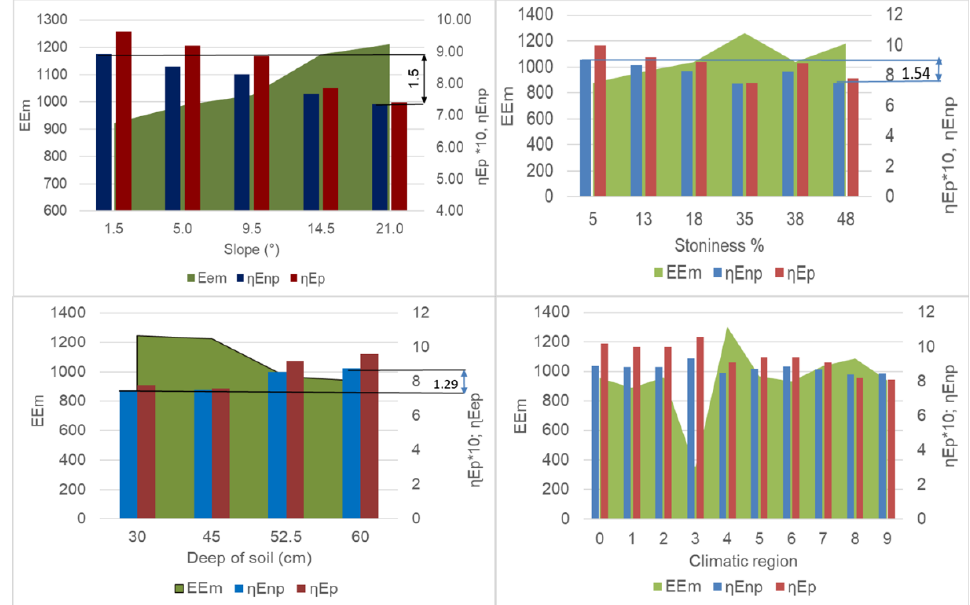
Figure 4. Main configuration and climatic properties and EGMo, GMo and EEm in average of crops.